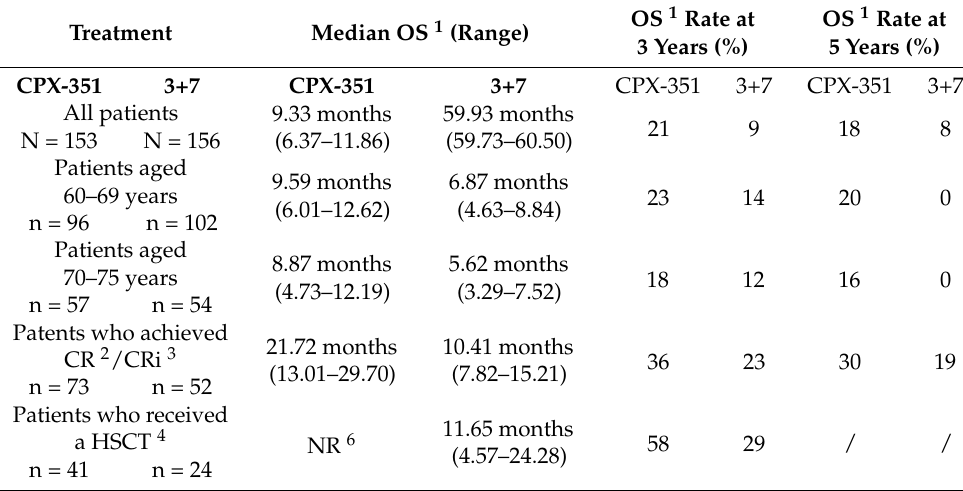
Table 1. Results from the 5-year phase III trial comparing efficacy of CPX-351 vs. “7+37+3” in high-risk AML patients (reference number